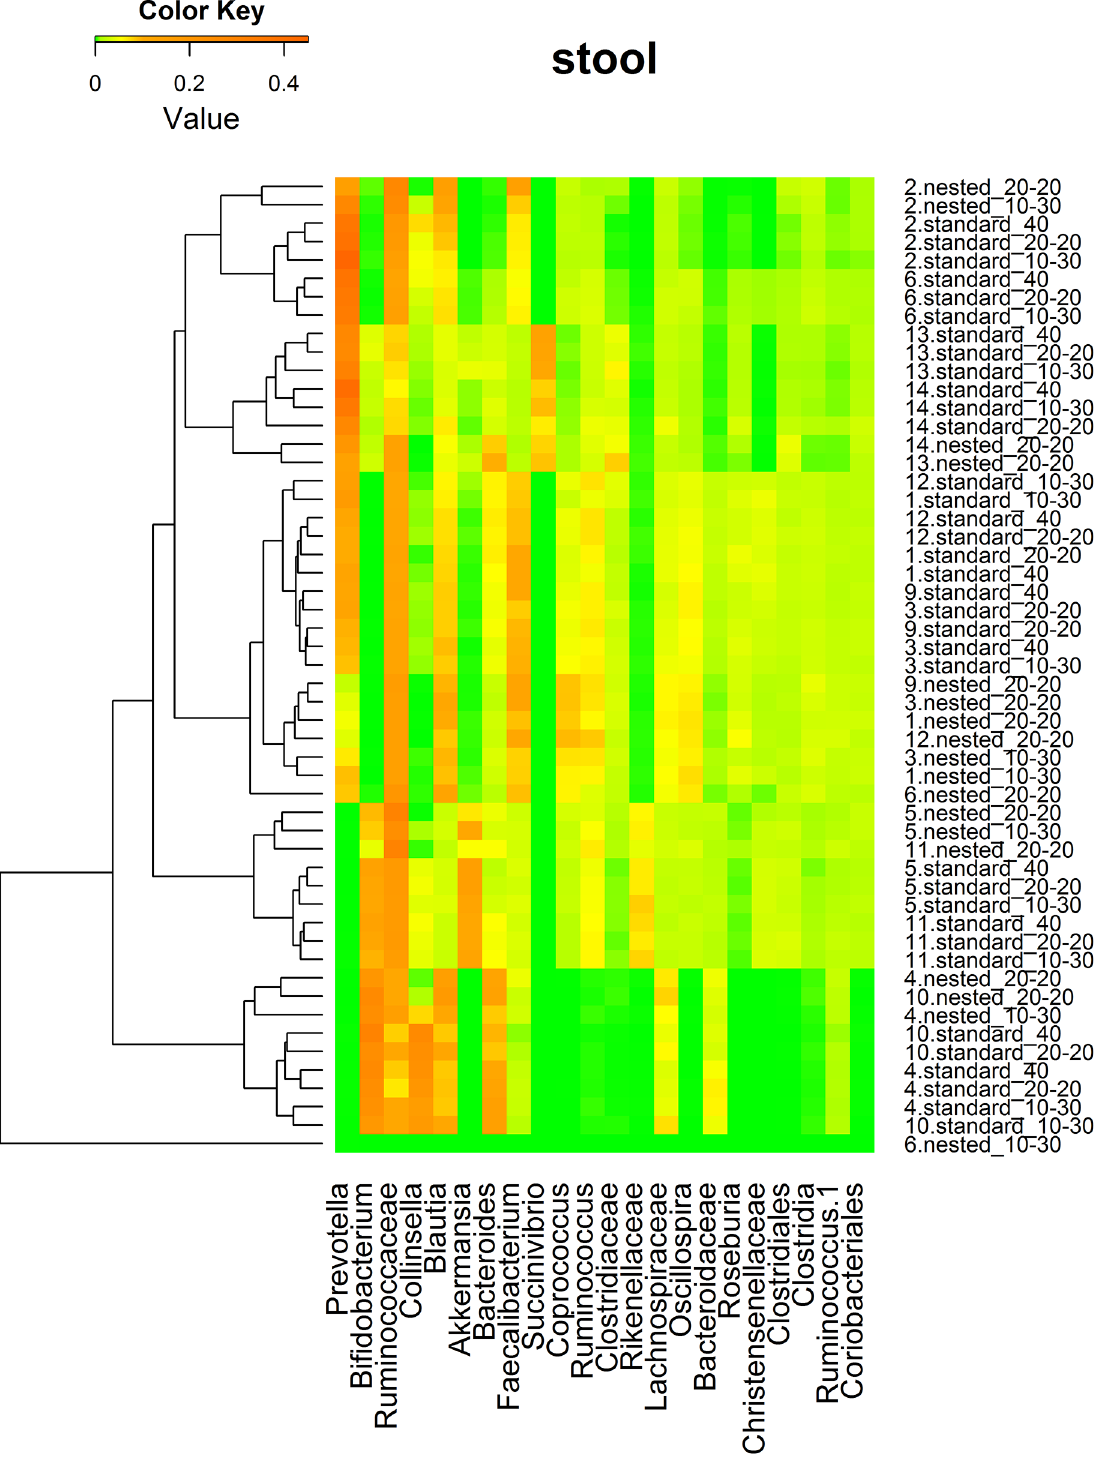
Fig 3. Clusters of stool samples based on bacterial genus relative abundance. Heatmaps were based on the hierarchical clustering solution (Bray- Curtis) distance metric and average clustering method. Row represents different sample ID (The number before the period is the subject ID; The text after the period is the PCR method used.). Columns represent the predominant bacterial genera with mean relative abundance of 0.01 or greater. The colors in the heatmaps represent the relative abundance of each genus, as indicated in the upper left corner of each panel.